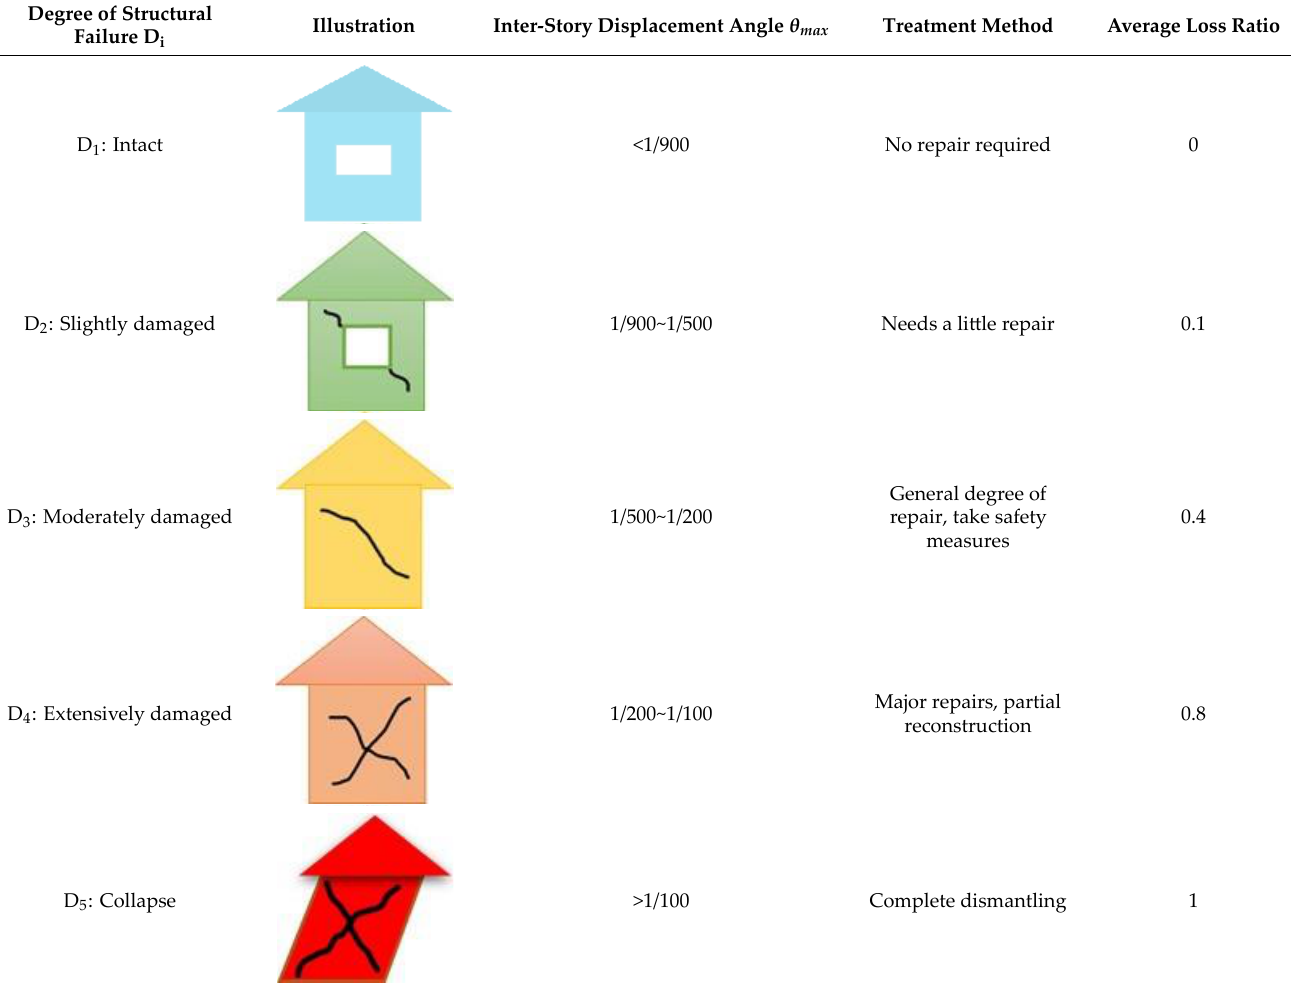
Table 1. The relationship between the degree of structural failure and the maximum inter‑story displacement angle and the loss ratio.